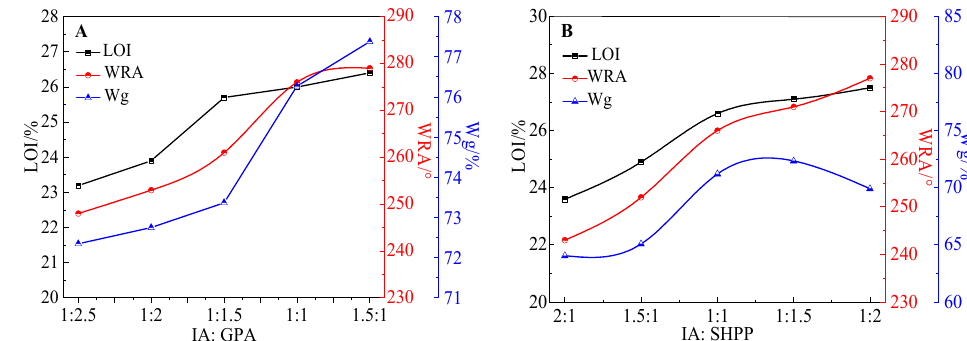
Figure 2. Effect of IA: GPA ( A ) and IA: SHPP ( B ) contents on cotton